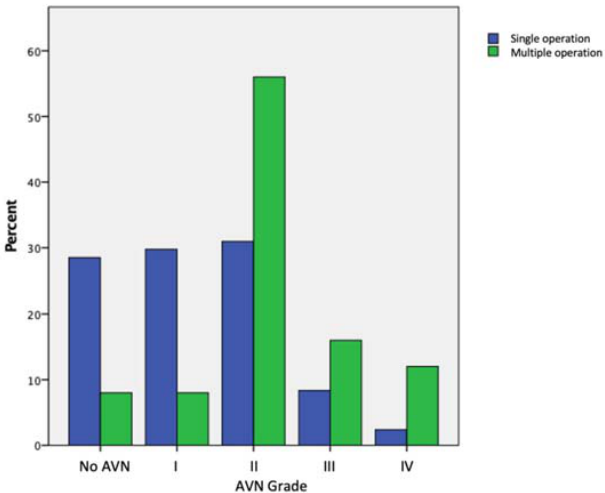
Figure 3. AVN grade frequency distribution for patients with single and multiple procedures.